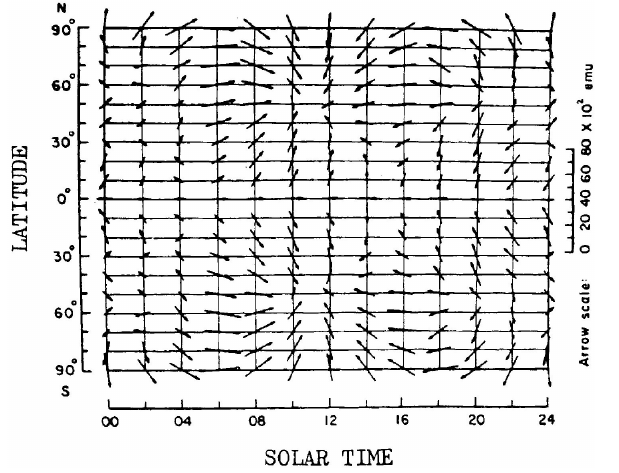
Figure 4. Tidal wind system in the E region derived from the geo- magnetic Sq variation (Maeda,